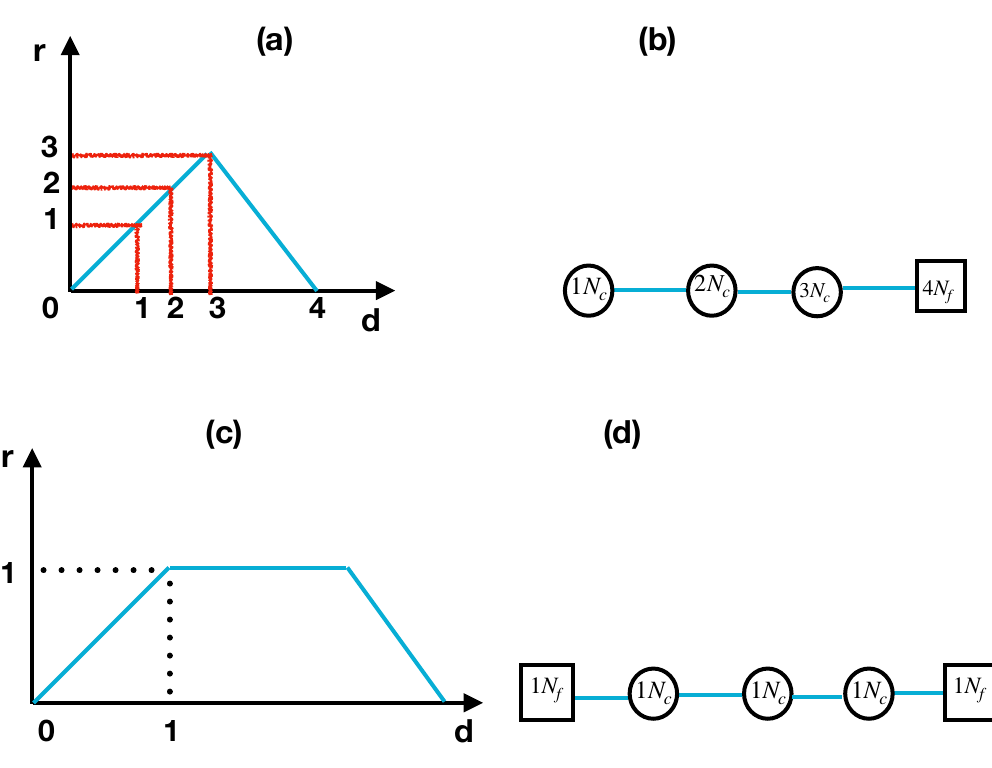
Figure 4 . (a)-(b) Quivers with single kink, (c)-(d) Quivers with a